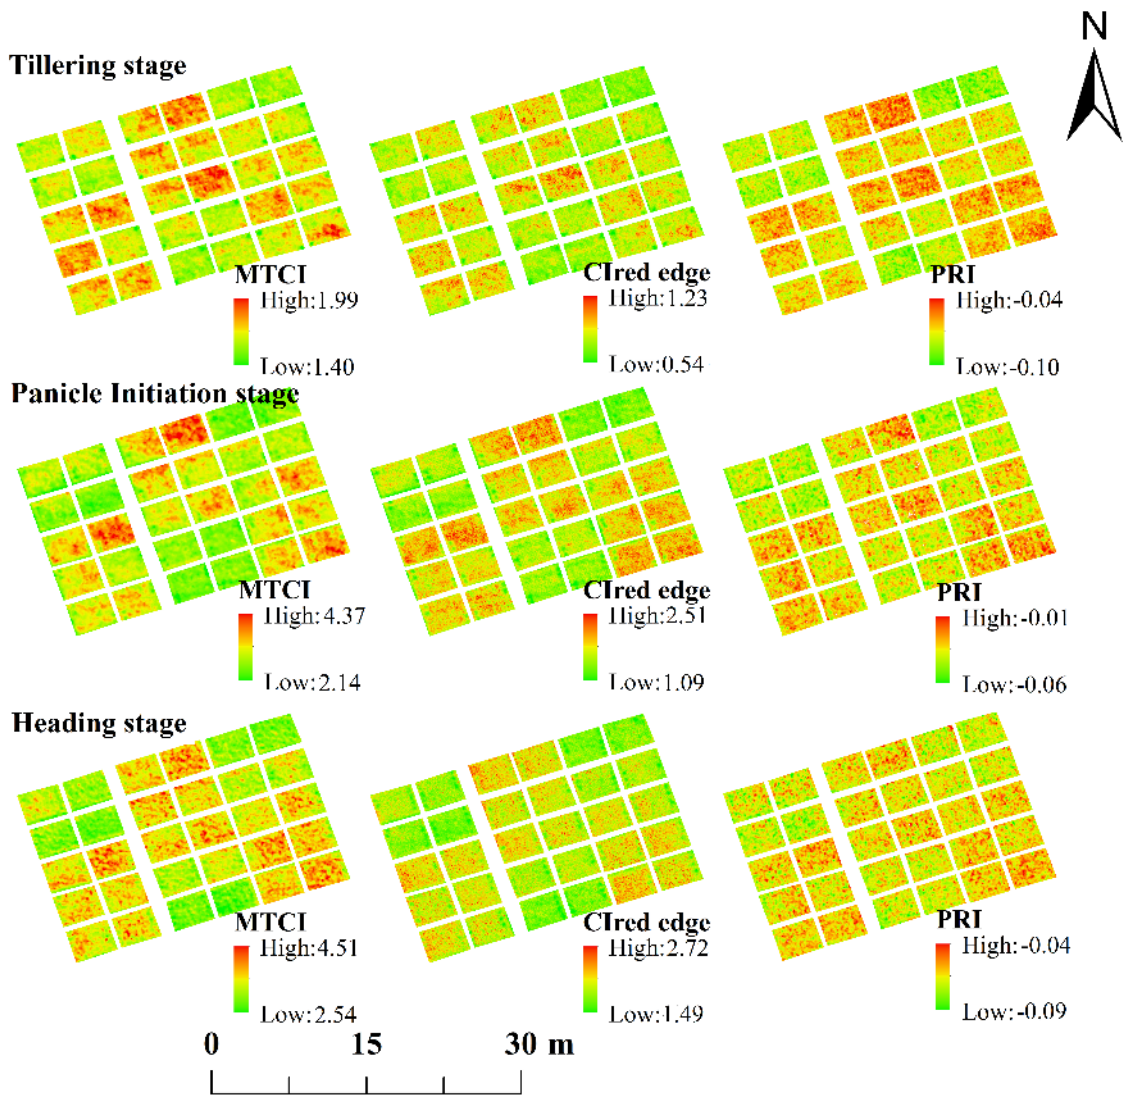
Figure A1. Rice vegetation index monitoring maps of the experimental area at different growth stages. Table A1. Two-factor multiple linear regression rice grain protein content (GPC) estimation models and their accuracy ( n = 15).